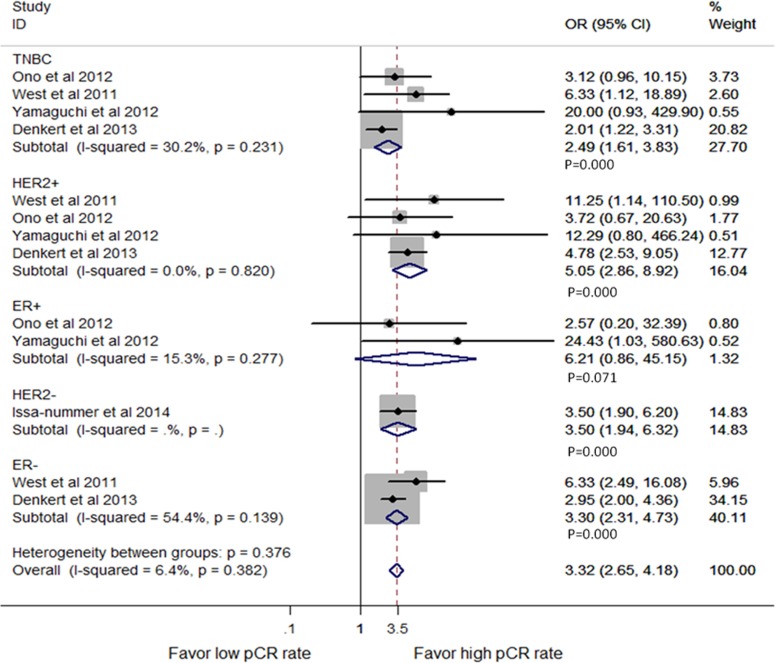
Forest plots from the fixed-effect meta-analysis of the efficacy of TILs on the NAC response stratified by different subtypes.The width of horizontal line represents 95% CI of the individual studies, and the grey boxes represent the weight of each study. The diamond represents the overall summary estimate. The unbroken vertical line was set at the null value (HR = 1.0). Abbreviations: TNBC, triple negative breast cancer; HER2, human epithelial growth factor receptor 2; ER, estrogen receptor.